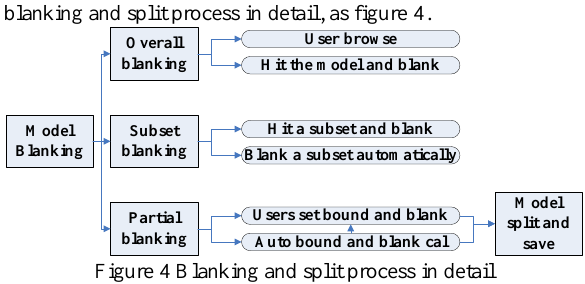
Figure 4 Blanking and split process in detail The blanking and segmentation of the model are event